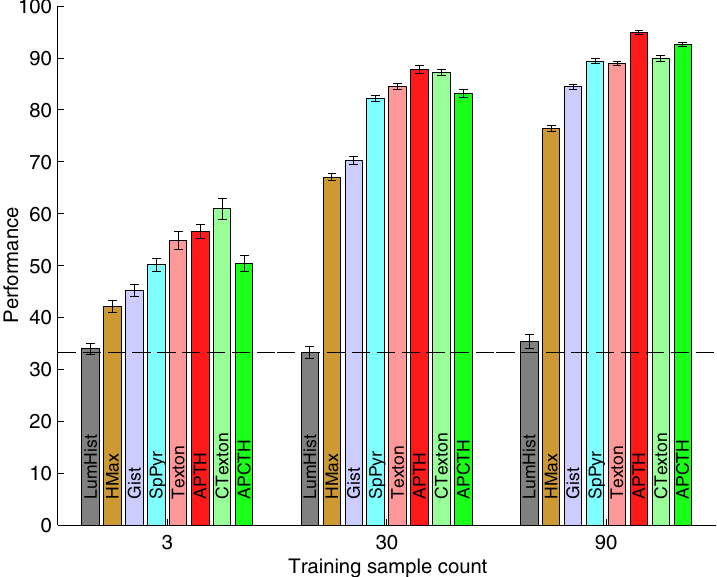
Figure 4 . Classi fi cation performance of room classi fi cation task in PC by feature vector for different number of training samples. Dashed line marks chance